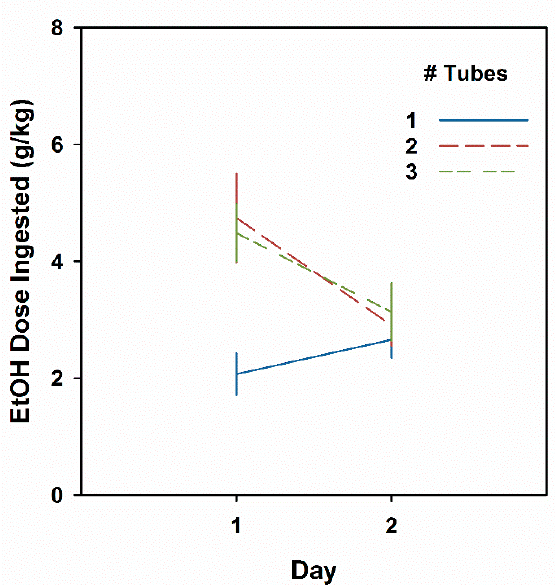
Figure 6. Male HDID-1 mice offered two or three tubes of EtOH drink more than those offered a single tube and show a CTA the next day. Mean ± SEM for groups of 15–16 mice offered one, two, or three tubes of 20% EtOH.